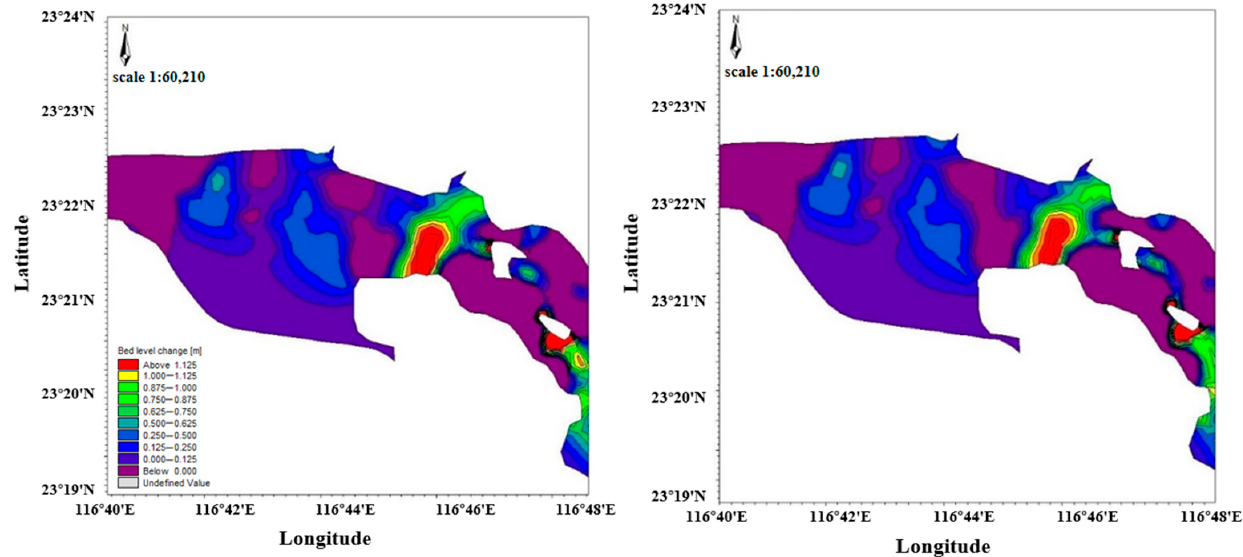
Figure 20. Comparison of Hanjiang River’s contribution to Shantou Port’s siltation. The left picture shows the real state, and the right picture shows that Hanjiang River’s silt is set to 0.